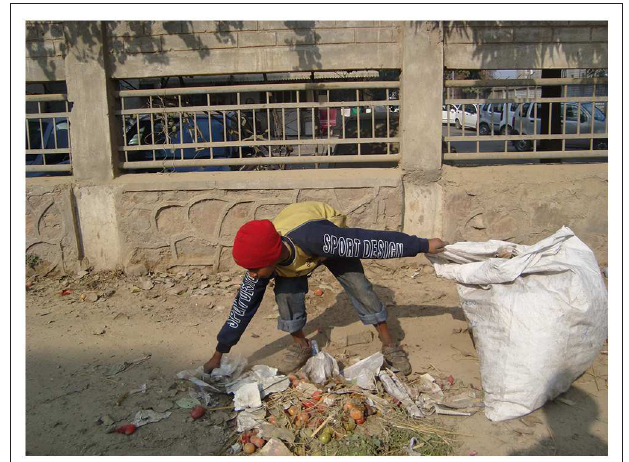
FIGURE 2 | Waste pickers go door to door collecting household waste, usually without pay.